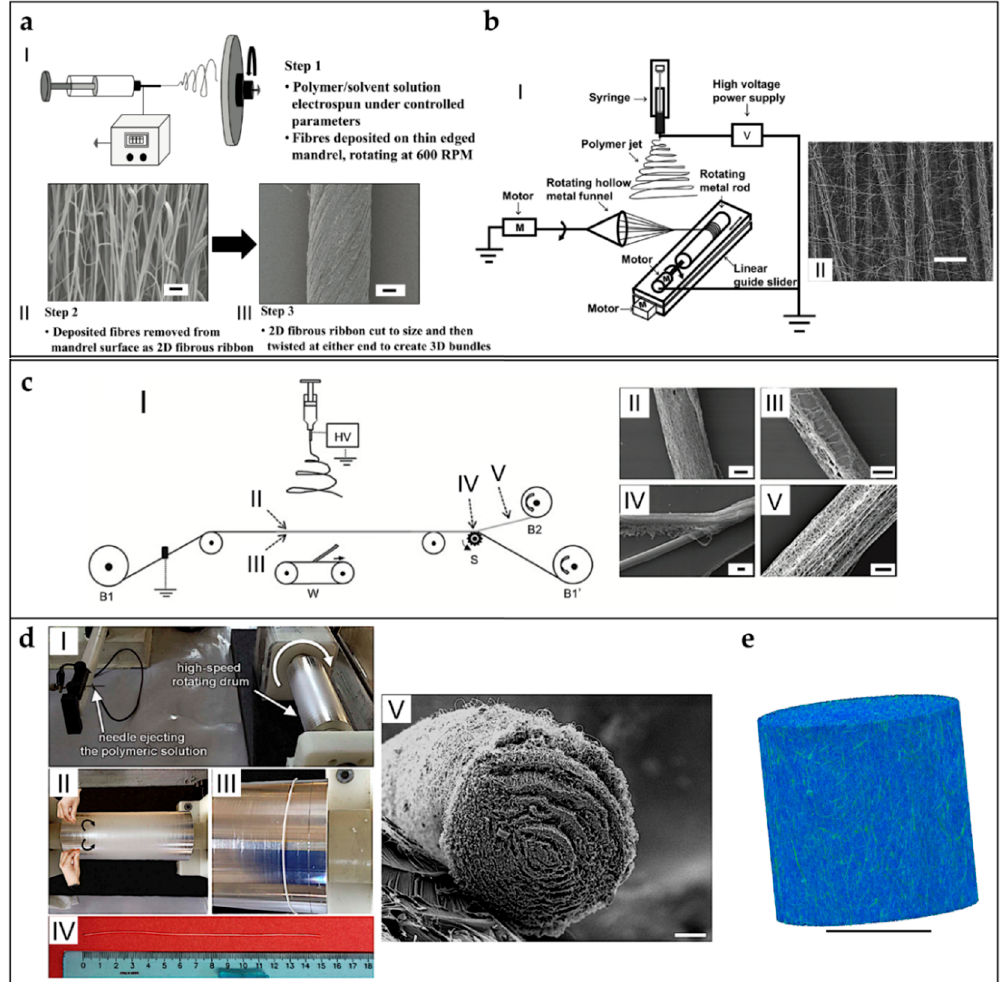
Figure 11. Different setups to produce nanofibrous bundles and yarns. ( a ) Yarns of PCL and